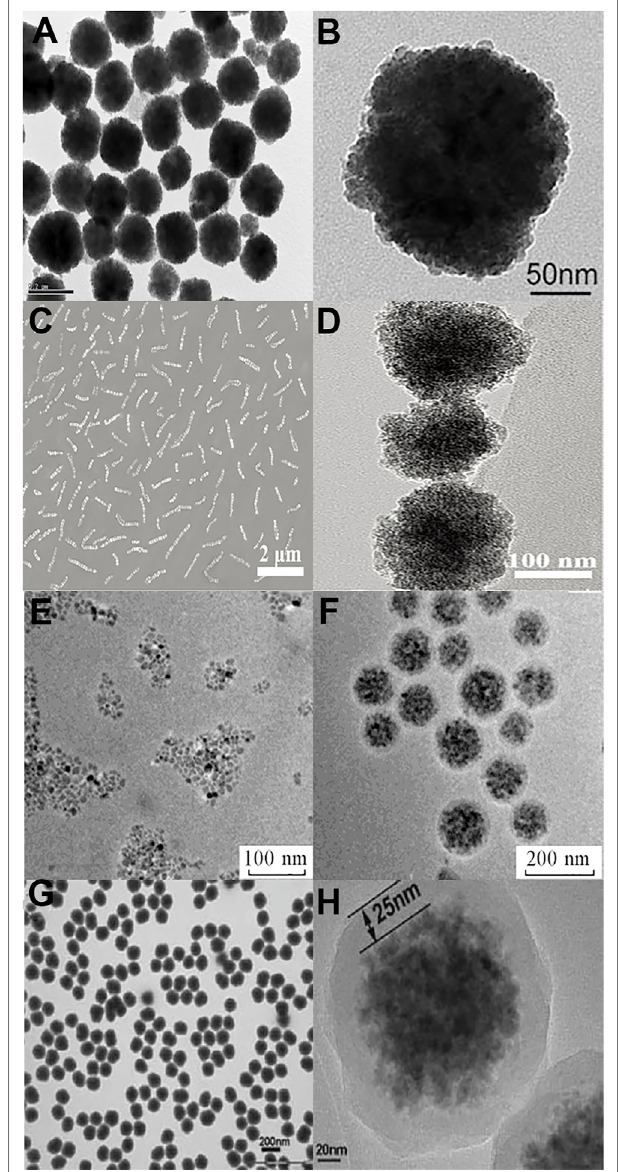
FIGURE 1 | (A) Representative TEM image and (B) High-magni fi cation TEM image of MNPs which use PAA as surfactant. Reprinted with permission from Ge et al. (2007). Copyright © 2007 John Wiley and Sons; (C) SEM image and (D) TEMimageofFe 3 O 4 @PVP@SiO 2 photonicnanorods.Reprinted with permission from Ma et al. (2017). Copyright © 2017 Royal Society of Chemistry; (E) TEM image of OA-Fe 3 O 4 , which shows that the mean size of OA-Fe 3 O 4 nanoparticles was 10 nm; (F) TEM image of MCNPs which was prepared from OA-Fe 3 O 4 nanoparticles by employing